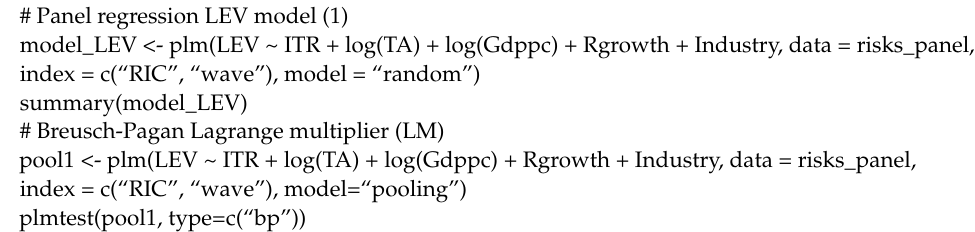
Algorithm A1 : Code selection in RStudio for panel estimation and LM test # Panel regression LEV model